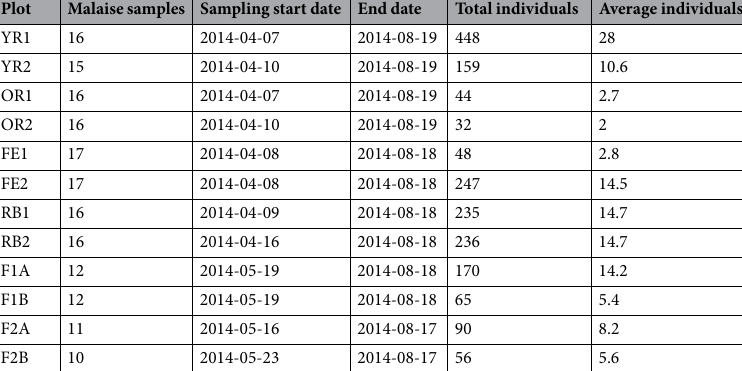
Table 1. Sampling details. Column 1 gives sample location (plot) ID, where YR = young rubber, OR = old rubber, FE = forest edge, RB = open river bank, F = natural forest interior. For each study plot, the number of malaise samples is given (Malaise collection replicates; samples usually taking place about once per week), along with the collection start and end dates, number of bee individuals caught in the sample and the